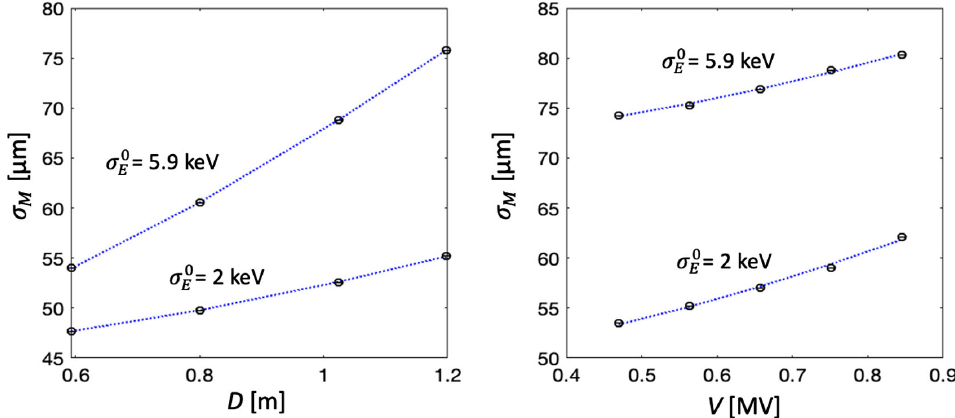
FIG. 11. Beam size σ M (black circles) from the dispersion scan and the TDS voltage scans as obtained from beam dynamics simulations. The blue dotted lines presents the curves of the numerical fit with Eq. (9) and Eq. (8).